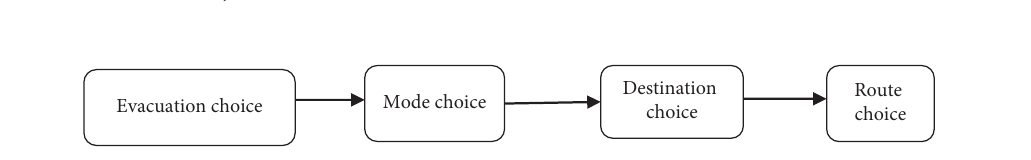
Figure 1: Decision-making stages in responding to earthquake disasters